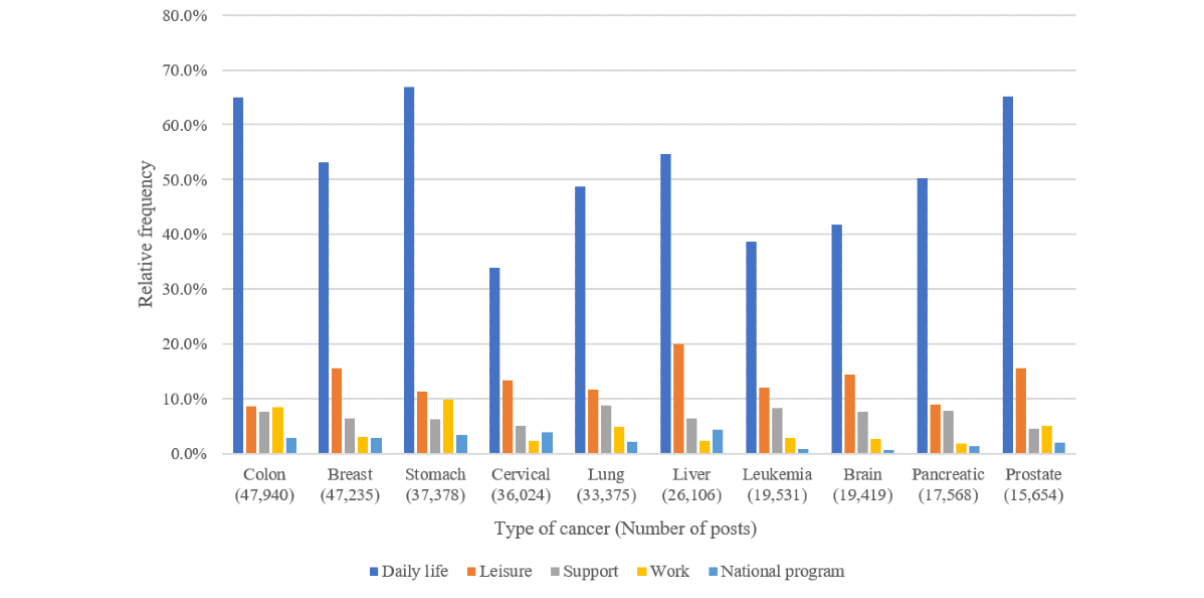
Figure 6. Relative frequencies of the dealing with cancer superclass by top 10 cancer types in social media posts.